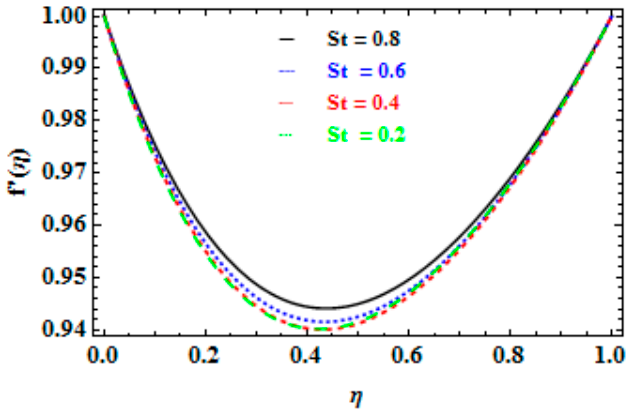
Figure 5. Influence of